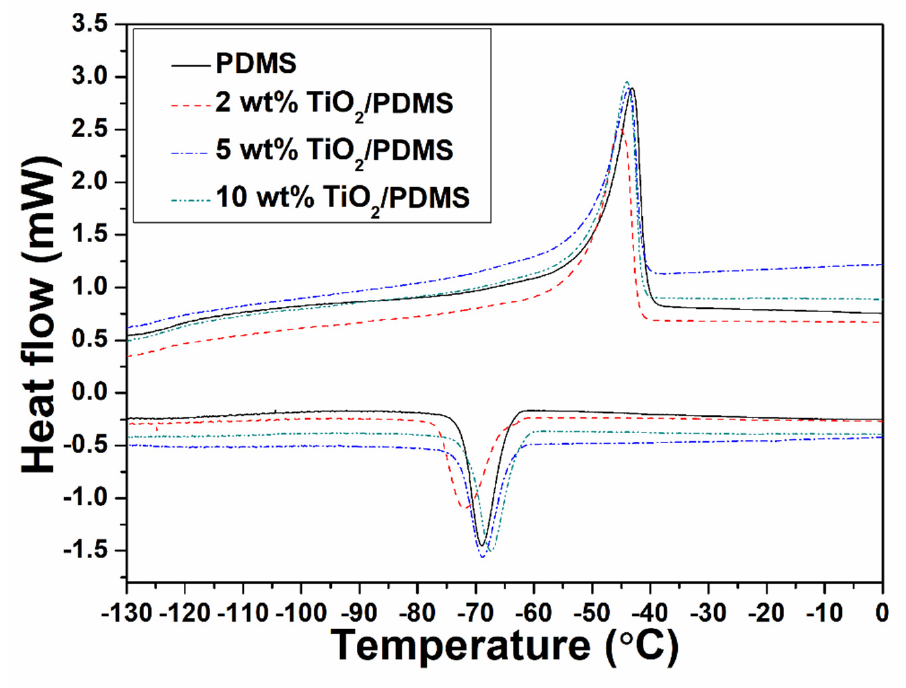
Figure 2. DSC curves of PDMS and TiO 2 /PDMS nanocomposites. Table 1. DSC results of PDMS and TiO 2 /PDMS nanocomposites.